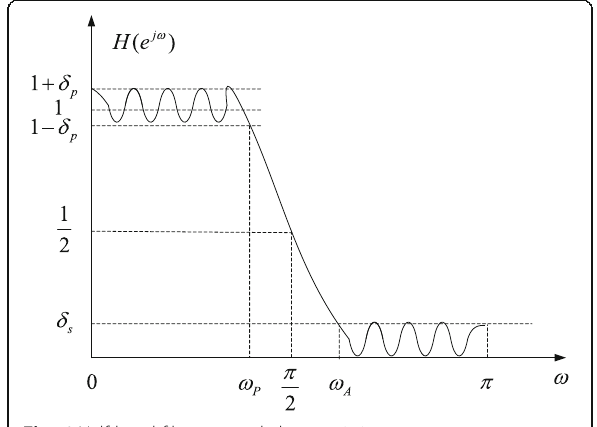
Fig. 6 Half-band filter spectral characteristics